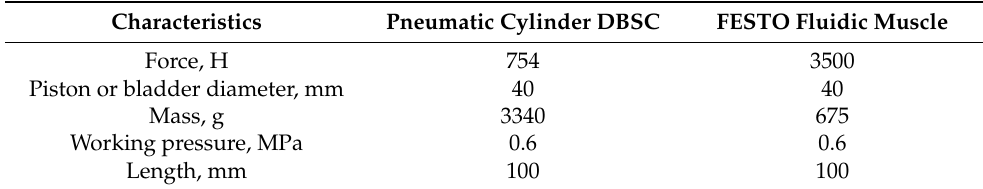
Table 2. Comparison between pneumatic cylinder DBSC and FESTO fluidic